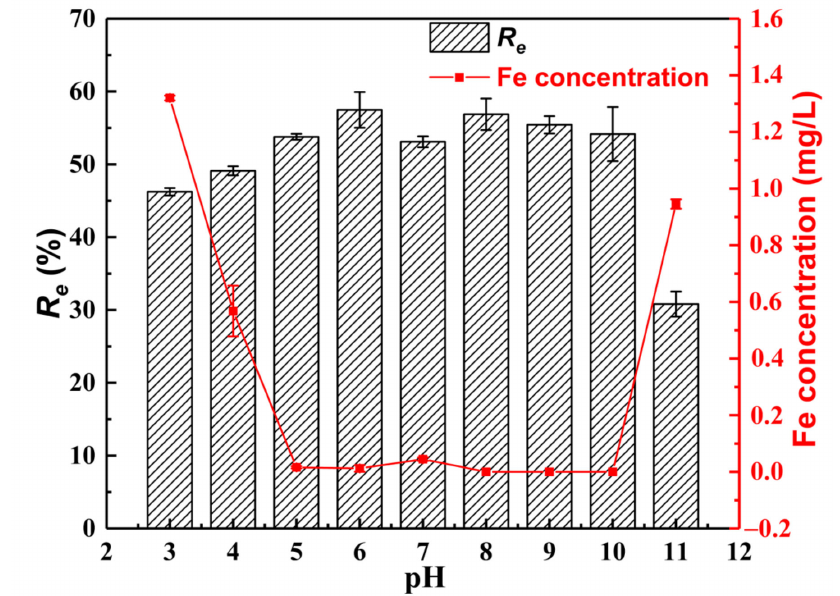
Figure 11. Changes in As(III) adsorption capacities ( Q e ) and removal efficiency ( R e ) as well as the concentrations of Fe in an aqueous solution after As(III) adsorption under varying